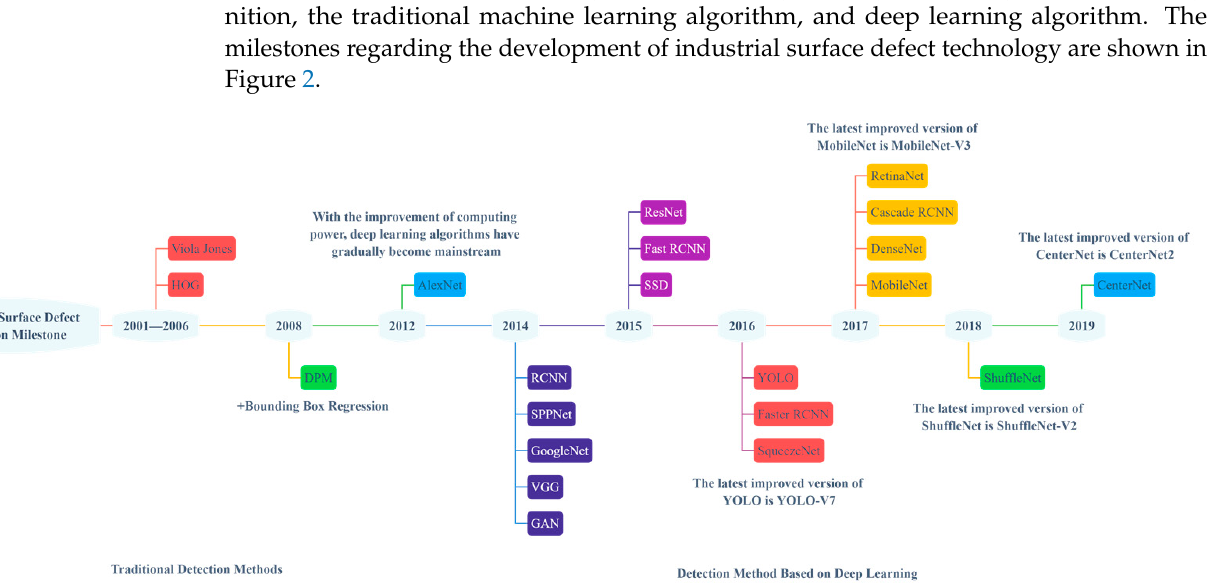
Table 1. Statistics of the steel surface defect categories.